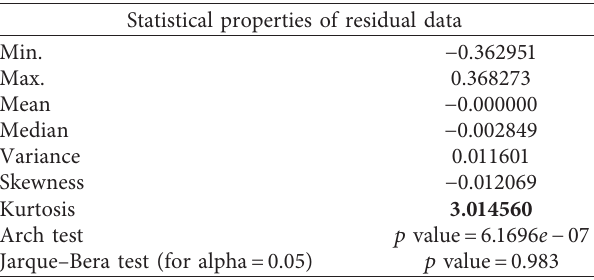
Table 3: Statistical properties of the residual data.